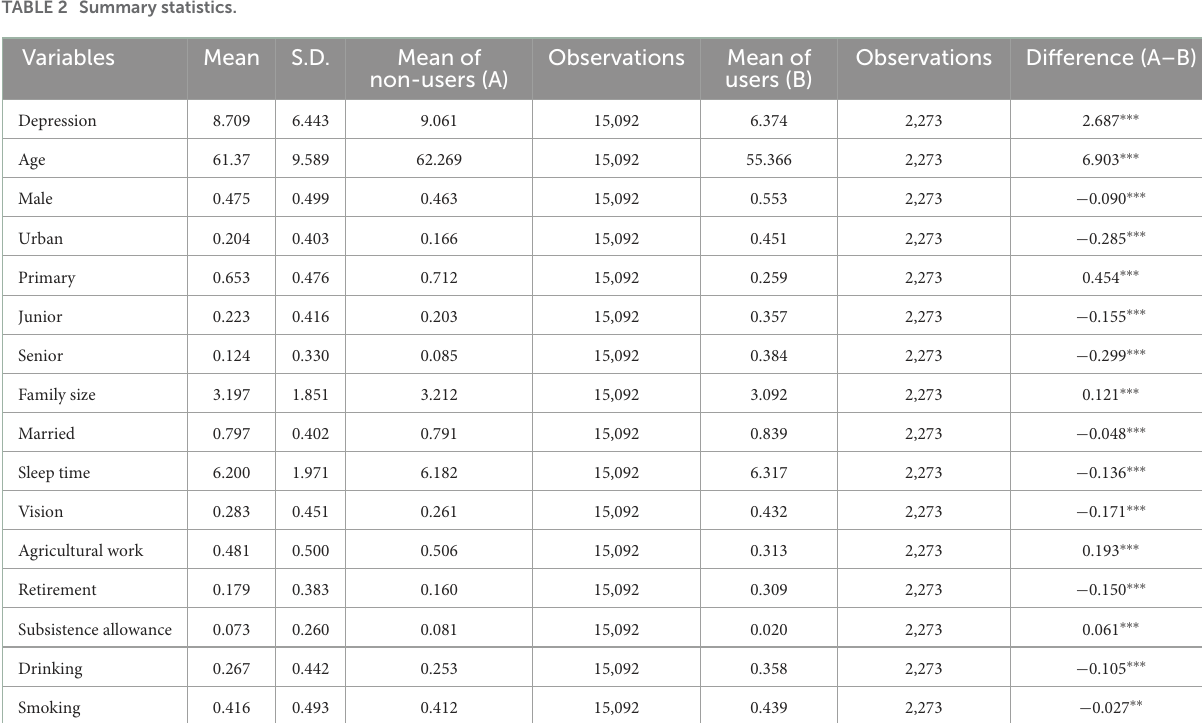
TABLE 2 Summary